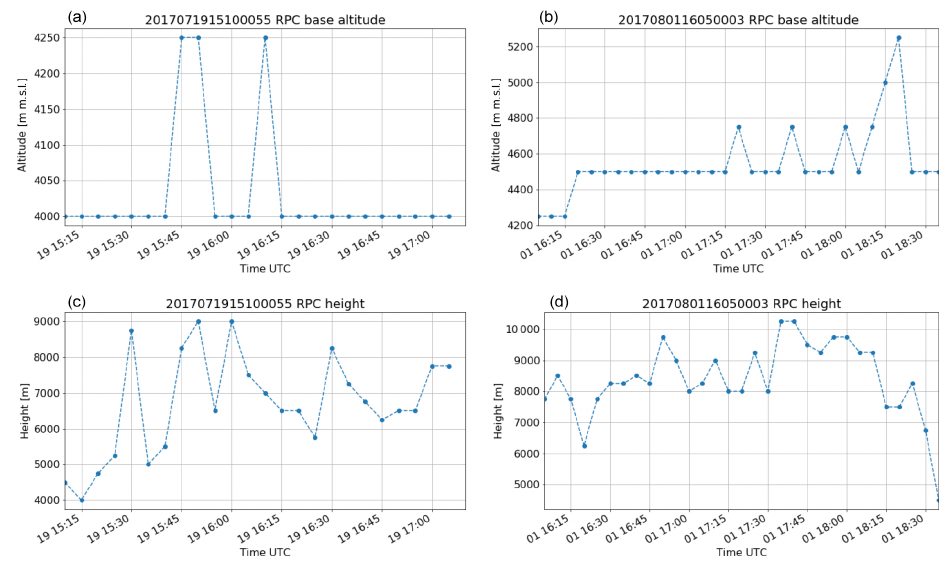
Figure 13. (a, b) RPC base altitude; (c, d) RPC height. (a, c) Cell 1; (b, d) cell